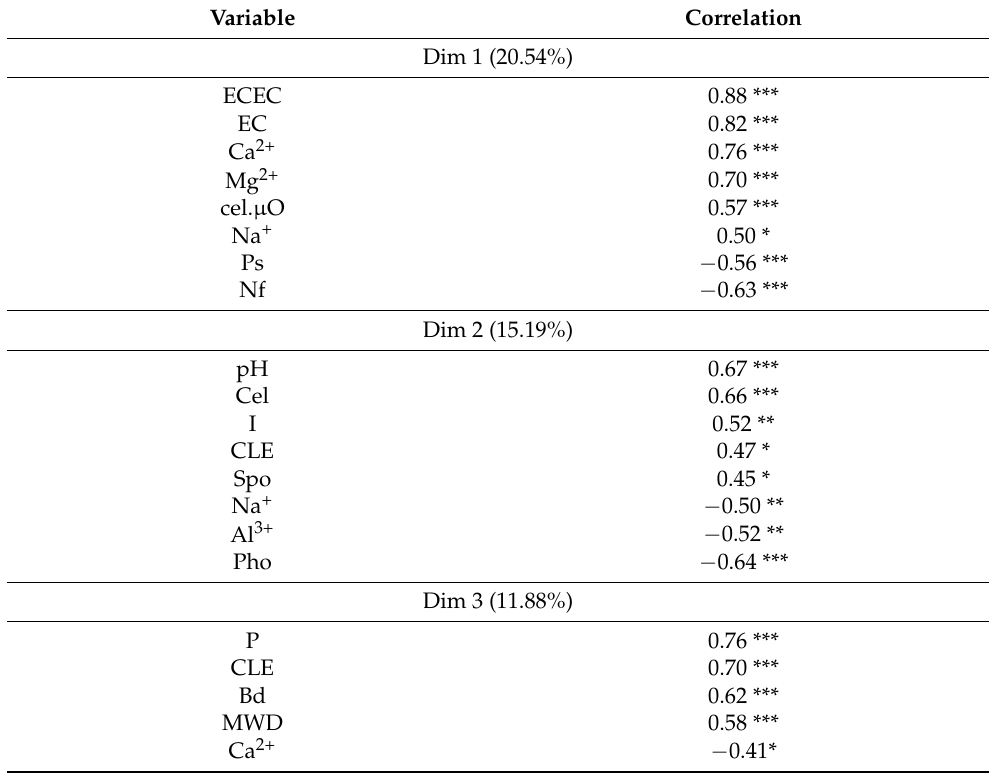
Figure 3. Principal components analysis variable factor map for physical, chemical, and biological variables measured in the rhizospheric soil of olive trees 105 days after pruning. The three first components or dimensions were extracted (Dim 1, Dim 2, and Dim 3). ( a ) Dim 1 vs. Dim 2; ( b ) Dim 1 vs. Dim 3. Table 3. Explained variance by principal components or dimensions Dim 1, Dim 2 and Dim 3, and correlation values of the measured variables with respect to each